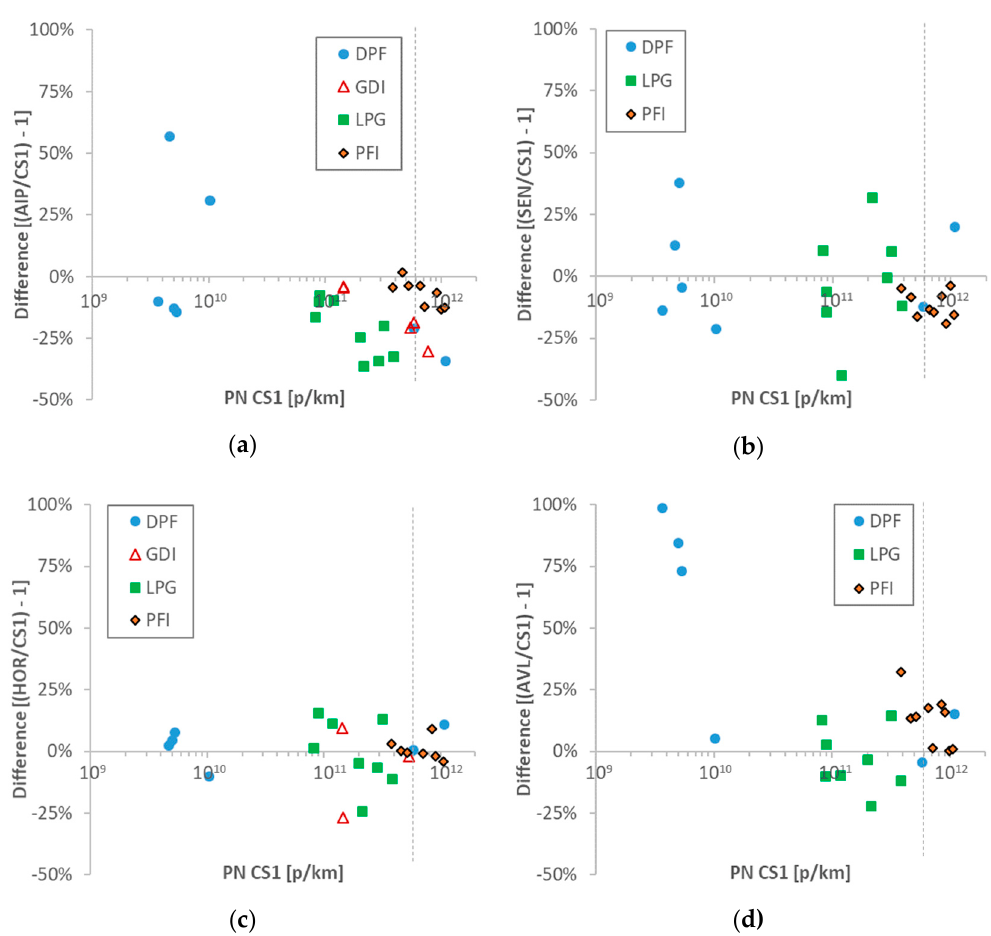
Figure 5. Comparisons of 10-nm particle number (PN) portable emissions measurement systems (PEMS) to reference CS1: ( a ) AIP; ( b ) Sensors (SEN); ( c ) Horiba (HOR); ( d ) AVL. Each point is a test cycle. The dotted vertical lines show the laboratory PN emissions limit (for > 23 nm). CS = catalytic stripper; DPF = diesel particulate filter; GDI = gasoline direct injection; LPG = liquefied petroleum gas; PFI = port fuel